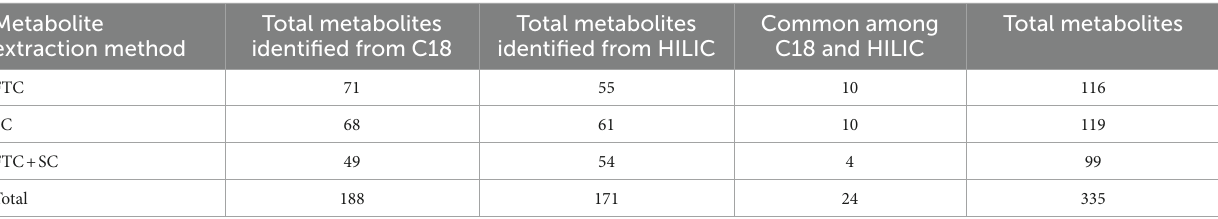
TABLE 1 Number of identified metabolites with respect to different metabolite extraction methods and chromatographic surfaces